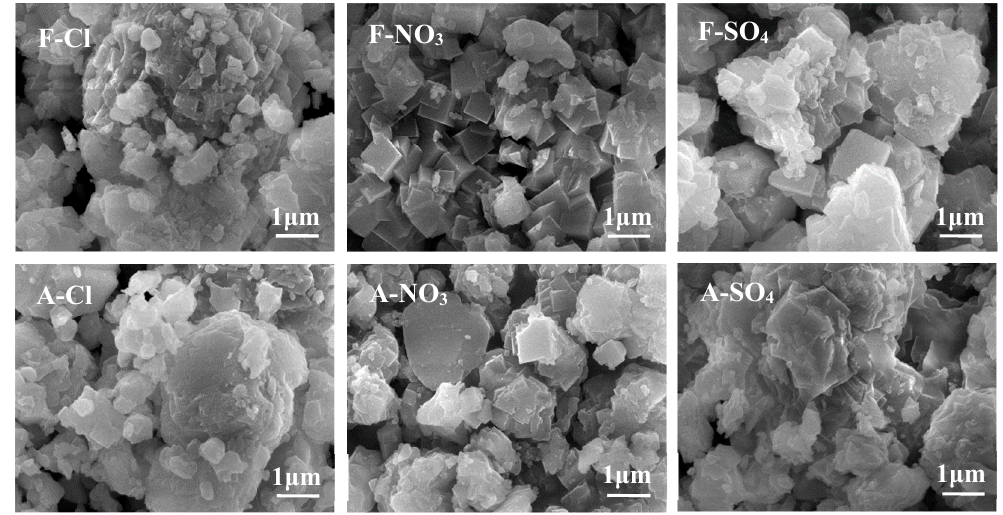
Figure 2. Scanning electron microscope (SEM) images of Cu II − SSZ − 13 catalysts before and after hydrothermal aging treatment.